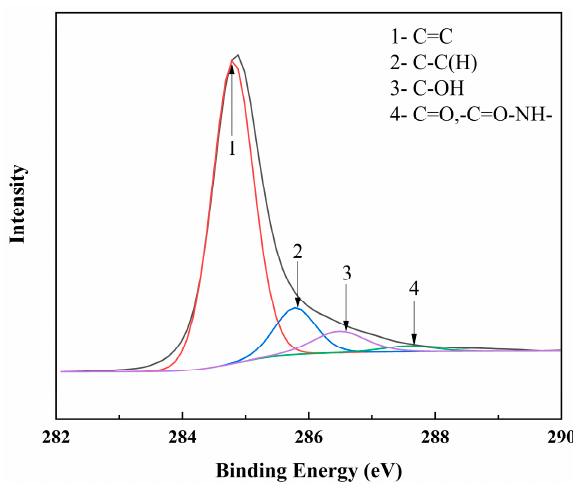
Figure 6. XPS of RGO heat treatment at 500 °C. The 2 θ of the 500 °C heat-treated RGO sheet increased from 24.06° to 25.74° (see Figure 7). According to the Bragg equation, higher-temperature heat treatment leads to random interlayer expansion and increased layer spacing. Volatilization of organic solvents adsorbed on the RGO surface and desorption of water between the layers led to gas generation between the layers. Cracks appeared between the graphene sheets, and the sheets became fluffy.